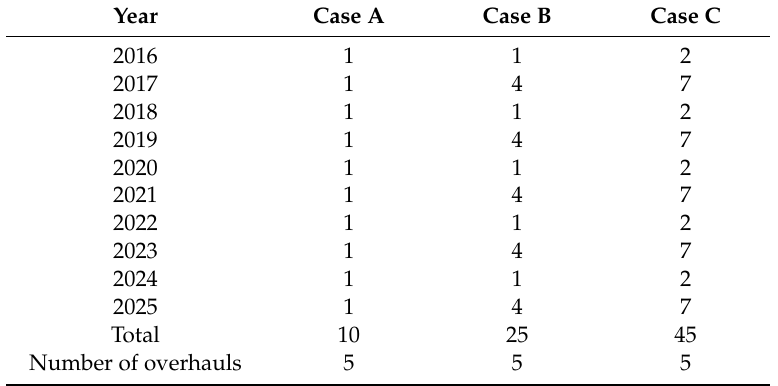
Table 14. Projected annual failures according to traditional method, base case and cheaper overhaul. Case A